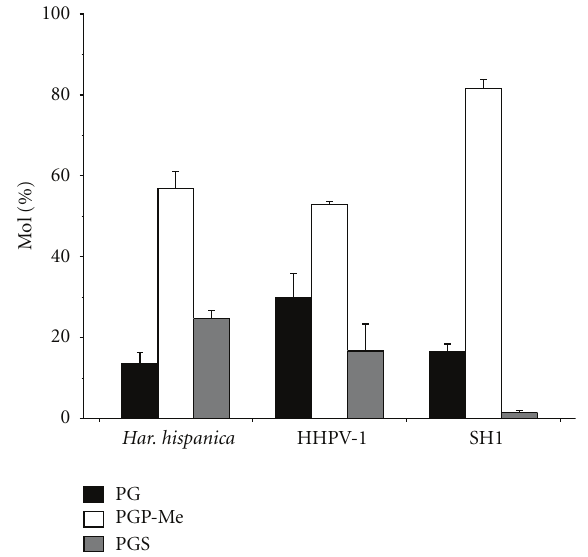
Figure 2: Comparison of the phospholipid compositions of Har. hispanica , HHPV-1 and SH1. Concentrations are expressed as the mol% of the total phospholipids. Only phospholipids representing more than 1% of the total are shown. Error bars represent standard deviations of data from at least three independent